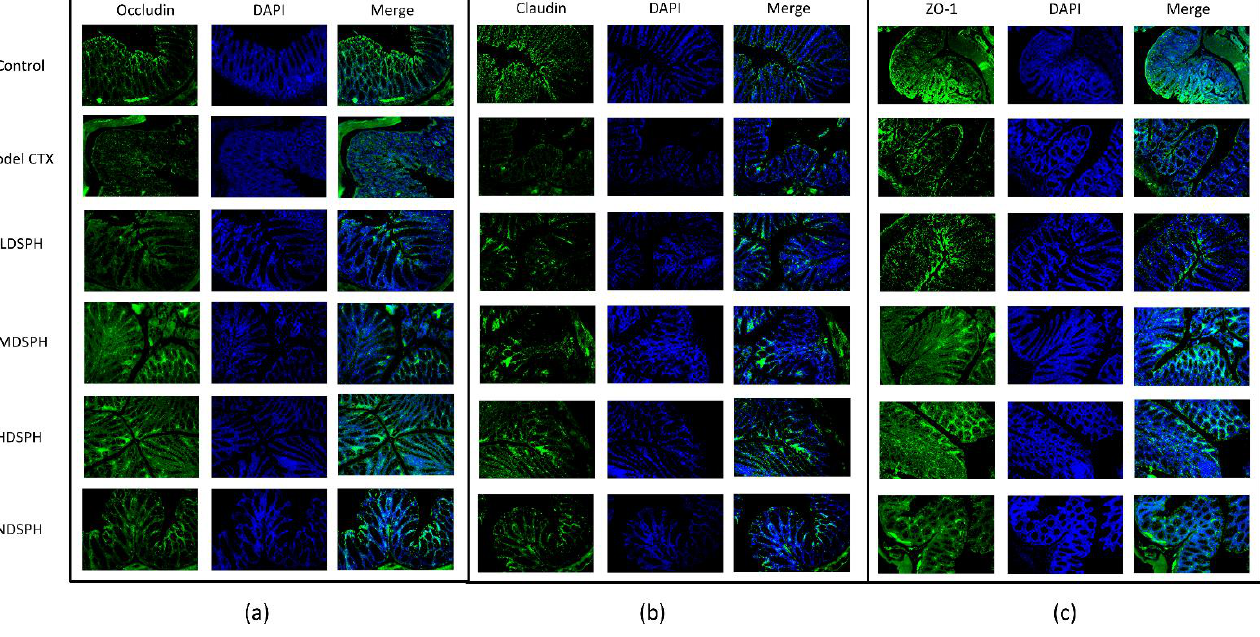
Figure 9. Immunofluorescent staining of tight junction proteins in the colonic epithelium ( a ) Occludin ( b ) Claudin ( c ) ZO-1. Original magnification 20 × , scale bar: 100 µ